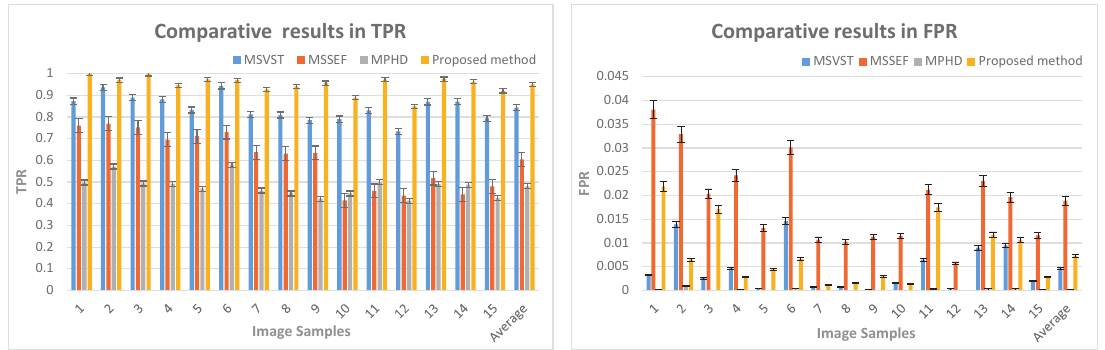
Figure 6. Comparison of TPR and FPR obtained with MSVST, MSSEF, MPHD and the proposed methods on fluorescent micro-droplet images (FMIs).